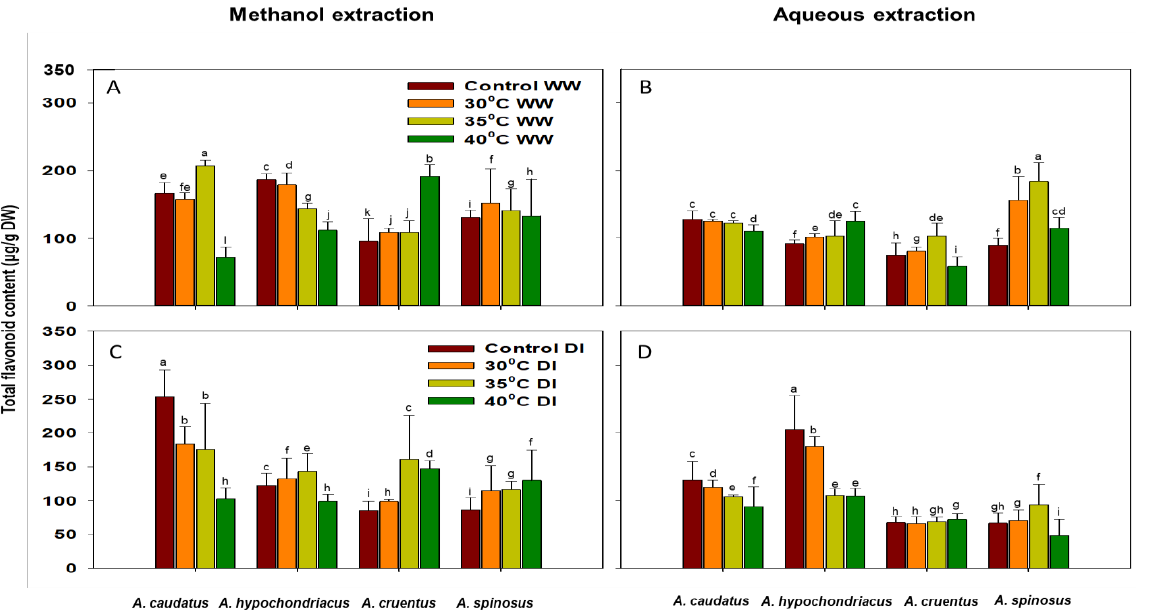
Figure 4. The effects of 30 °C, 35 °C and 40 °C temperature regimes under well-watered (WW) ( A , B ) and water-stressed (DI) ( C , D ) conditions on the accumulation of total flavonoid content (TFC) of A. caudatus , A. hypochondriacus , A. cruentus and A. spinosus . Each vertical bar represents the mean value, and vertical line is a mean standard error (±) at 95% confidence level. Values among each species with the same letter(s) are not significantly different at p ≤ 0.05.